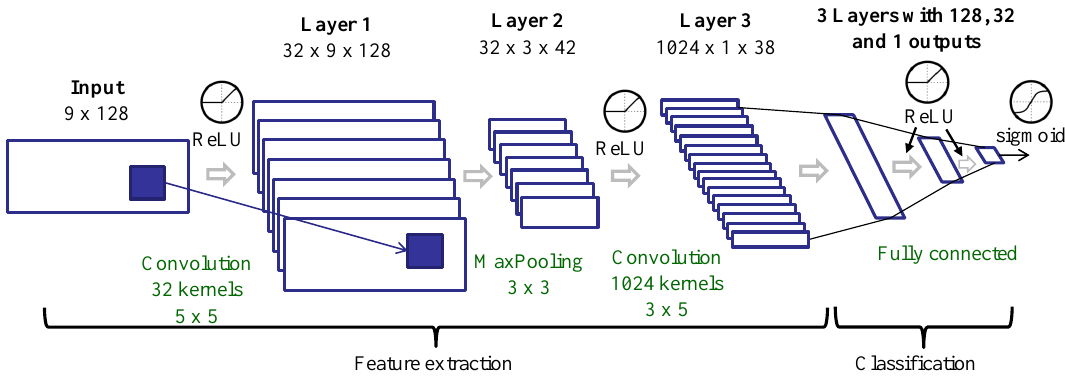
Figure 6. Deep learning architecture for training on spectra after tremor spectrum